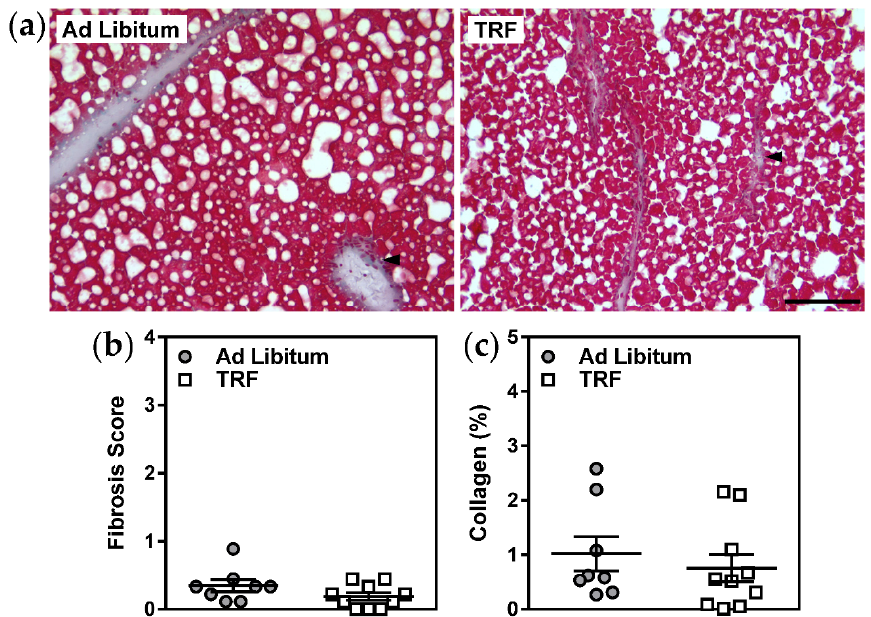
Figure 3. Two-week TRF does not alter liver fibrosis in obese mice. ( a ) Liver tissue sections were stained with Masson’s trichrome to visualize tissue fibrosis (collagen; blue, black arrows). ( b , c ) Fibrosis scores (from 0 to 4) and collagen tissue areas were assessed in 3 serial sections per mouse. Scale bar represents 100 µm. Data are means ± SEM, n = 8–10.